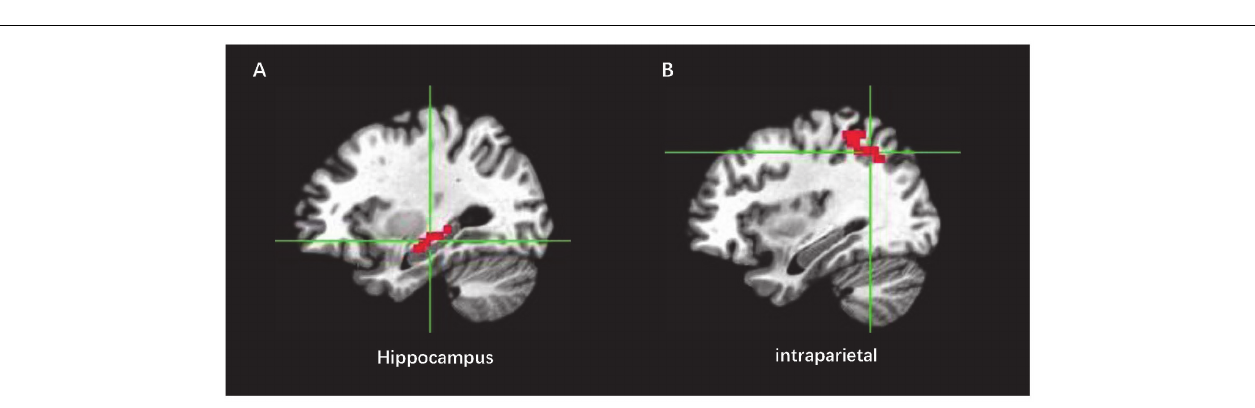
FIGURE 4 | Locations for the feedback and control localizer brain regions in Talairach space: (A) ROI EXP indicates the NF region in the right hippocampus, and (B) ROI con represents the control NF region in the intraparietal